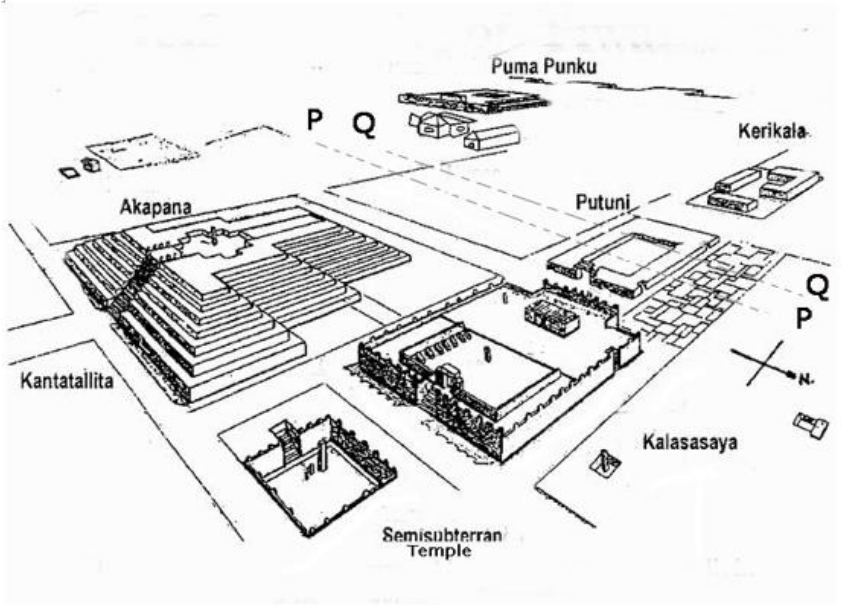
Figure 44. Details of elite and administrative structures within the moat and subterranean P, Q pipelines (from [2]).